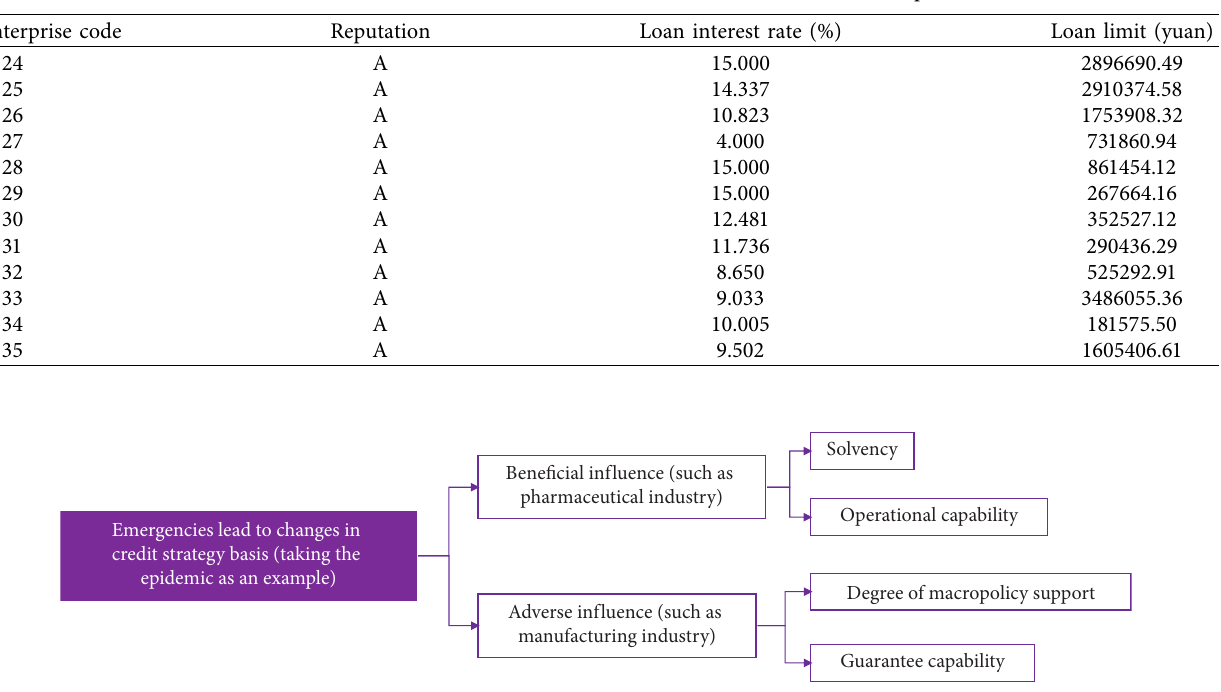
Figure 6: Credit adjustment strategy model under the influence of